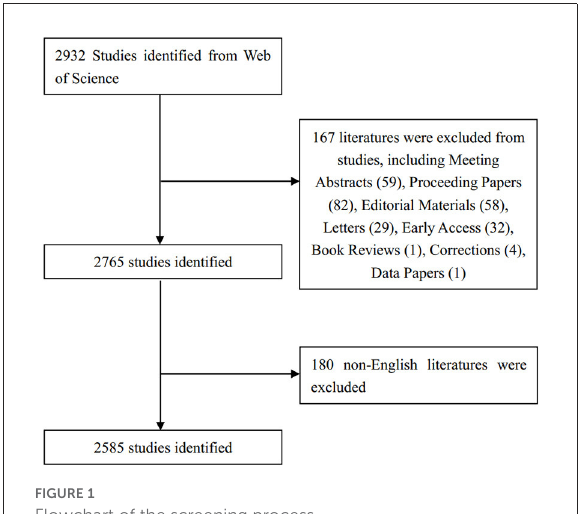
FIGURE1 Flowchart of the screening